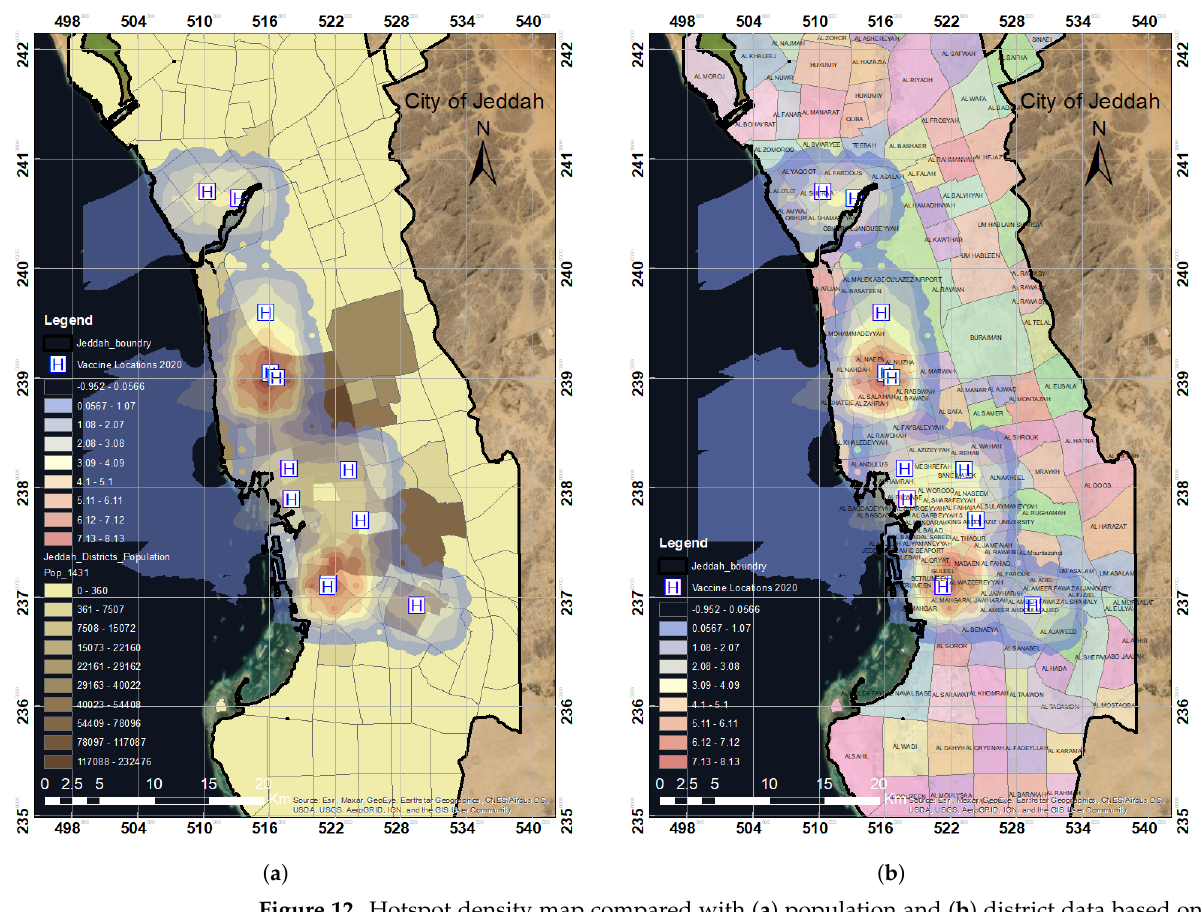
Figure 12. Hotspot density map compared with ( a ) population and ( b ) district data based on the spatial distribution of the COVID-19 vaccination centers established in Jeddah in 2020. ( a ) Hotspot density vs. population. ( b ) Hotspot density vs.